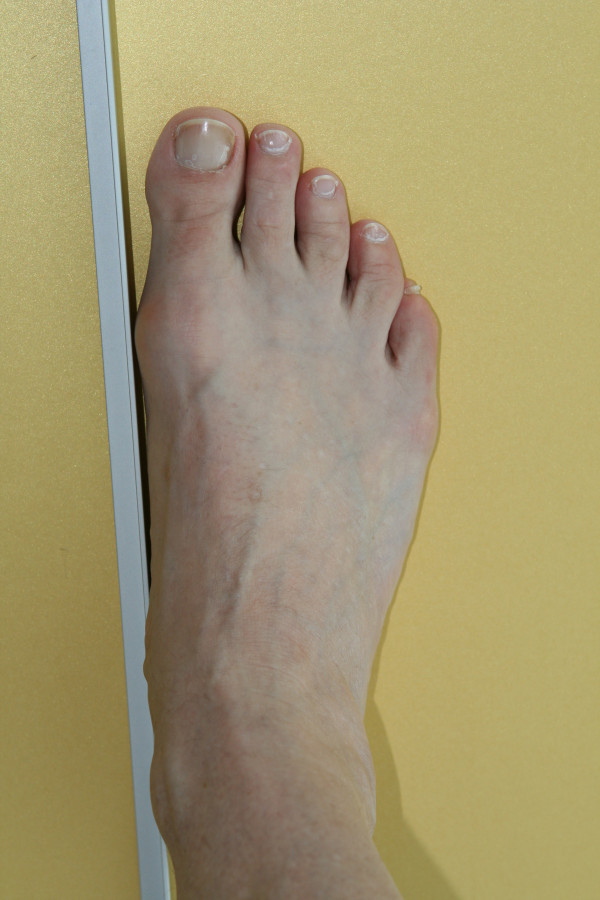
Metal strip placement for the x-ray imaging of the margo medialis pedis.